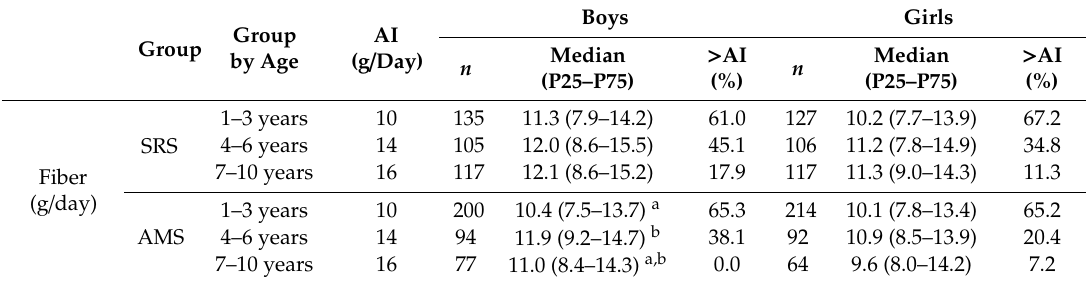
Table 4. Fiber usual intake and prevalence of adequacy (percentage of population > AI) by gender and age group in the Spanish Pediatric Population (EsNuPI) study.